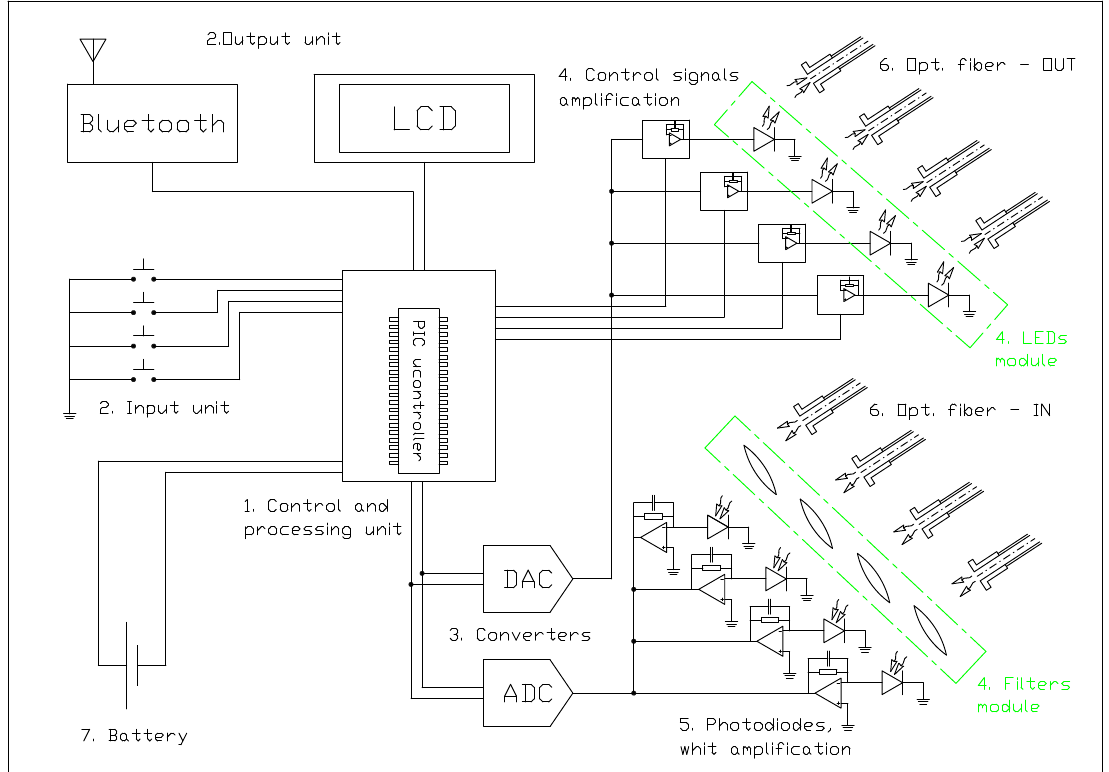
Figure 1. Block diagram of the main components of the